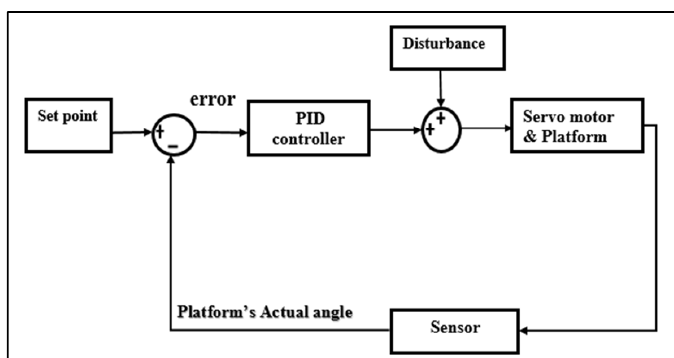
Fig. 1. The block diagram of Simscape / Simulink model of self-balancing platform on the mobile car.